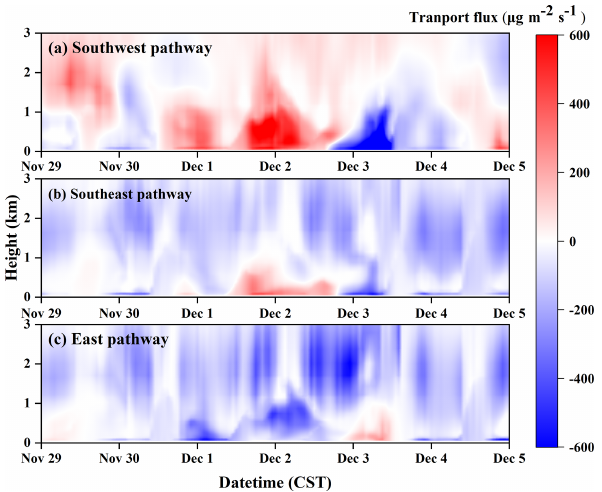
Figure 9. Time series of PM 2 . 5 transport flux from different trans- port pathways. The corresponding directions of the southwest, southeast, and east pathways are shown in Fig. 1.